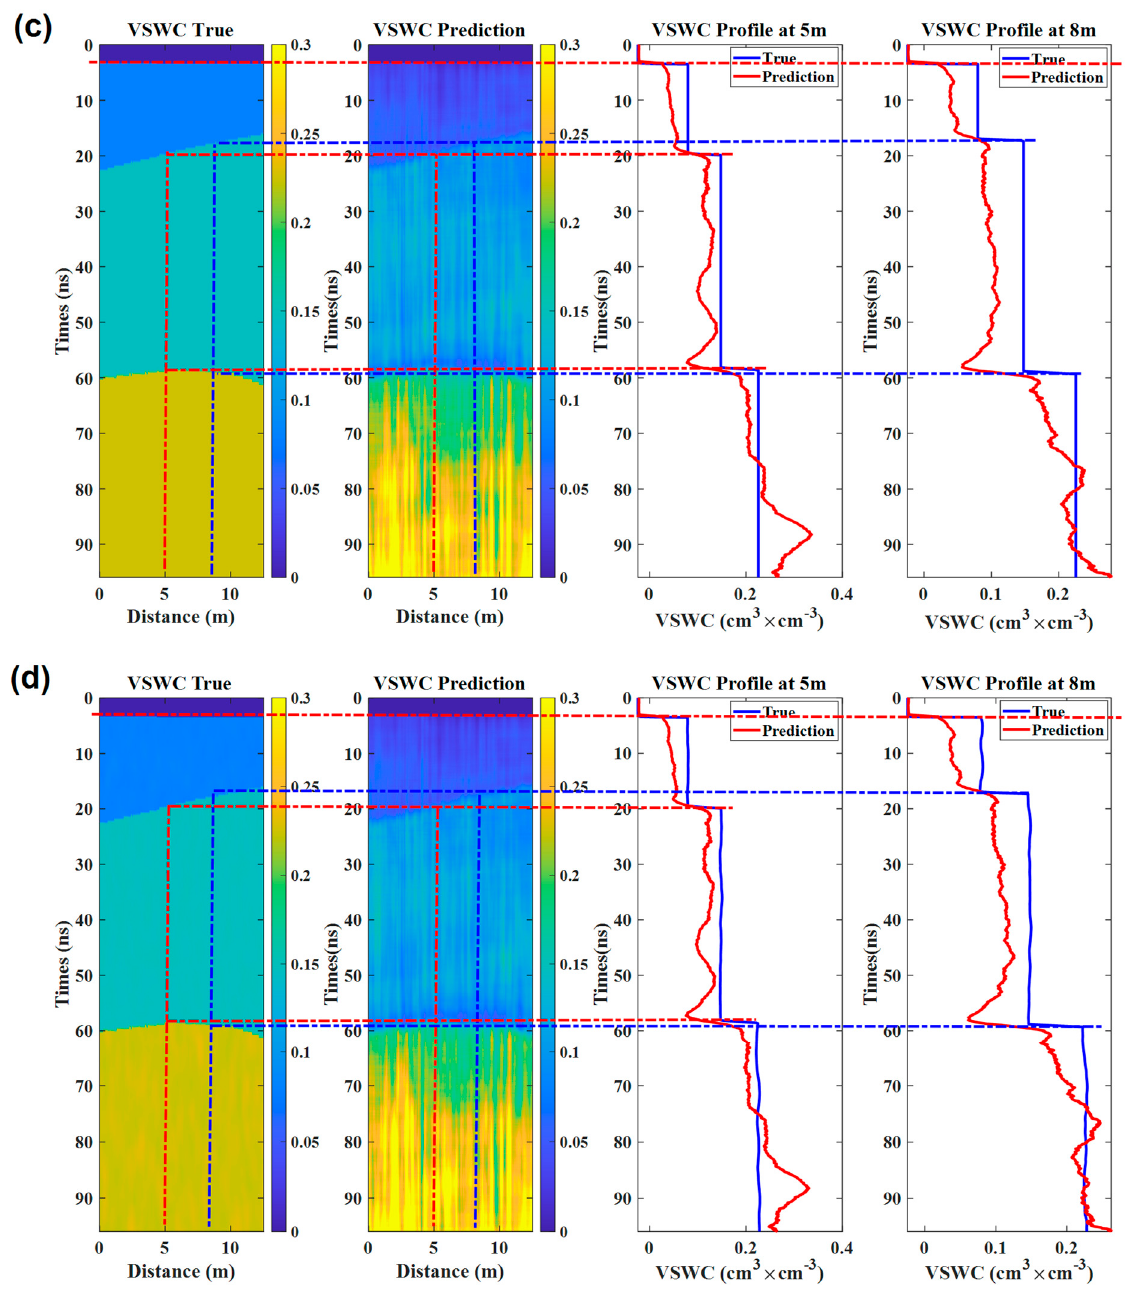
Figure 5. Synthetic experiments to evaluate the effectiveness of the GPRSW. ( a ) Horizontal layered media water content model; ( b ) horizontal stochastic media water content model; ( c ) undulating-interface layered media water content model; ( d ) undulating-interface stochastic media water content model. Red dashed lines indicate VSWC boundaries in different depth domains in the horizontal media. In the undulating media, red and blue dashed lines mark VSWC boundaries at 5 and 8 m from the starting point, respectively.